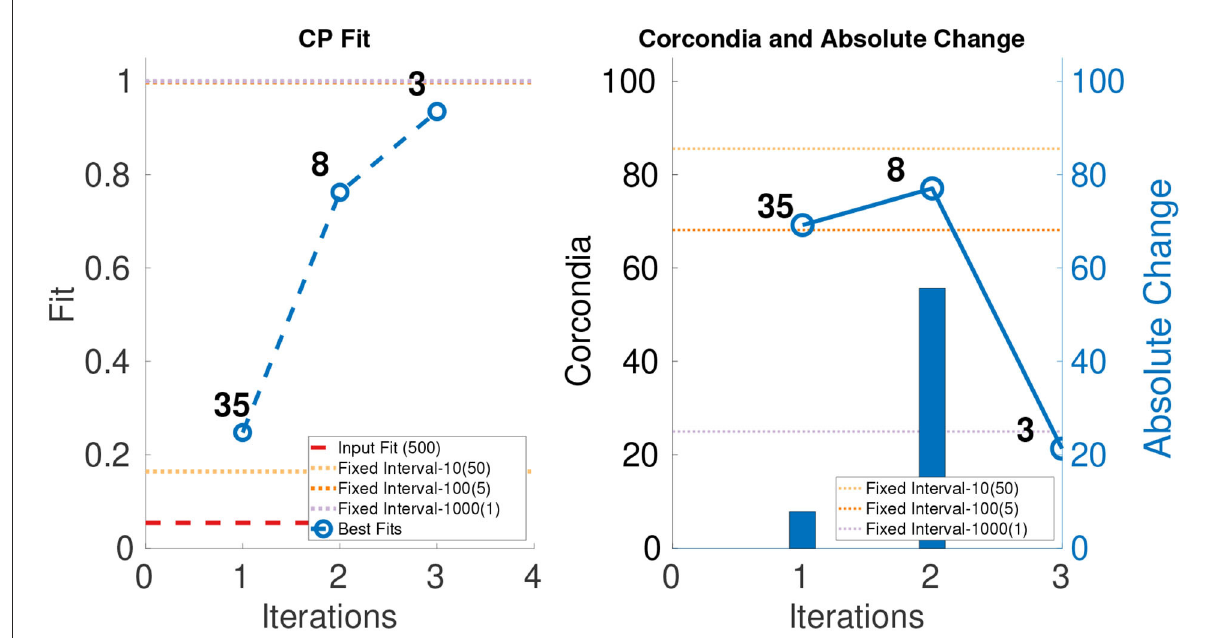
FIGURE3 CANDECOMP/PARAFAC (CP) fit and Core Consistency Diagnostic (CORCONDIA) of best fit tensor and its absolute change at each iteration for SD1.